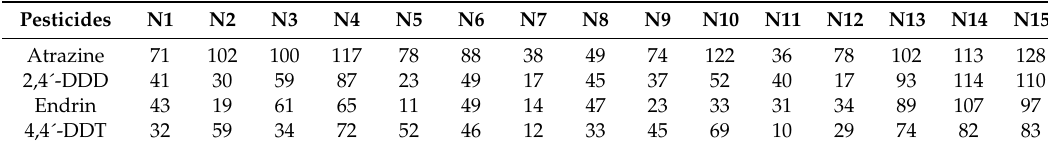
N: Experiment number. Table 2. Recovery (%) of the analytes obtained using a Box–Behnken DoE. Table 2. Recovery (%) of the analytes obtained using a Box–Behnken DoE. Pesticides